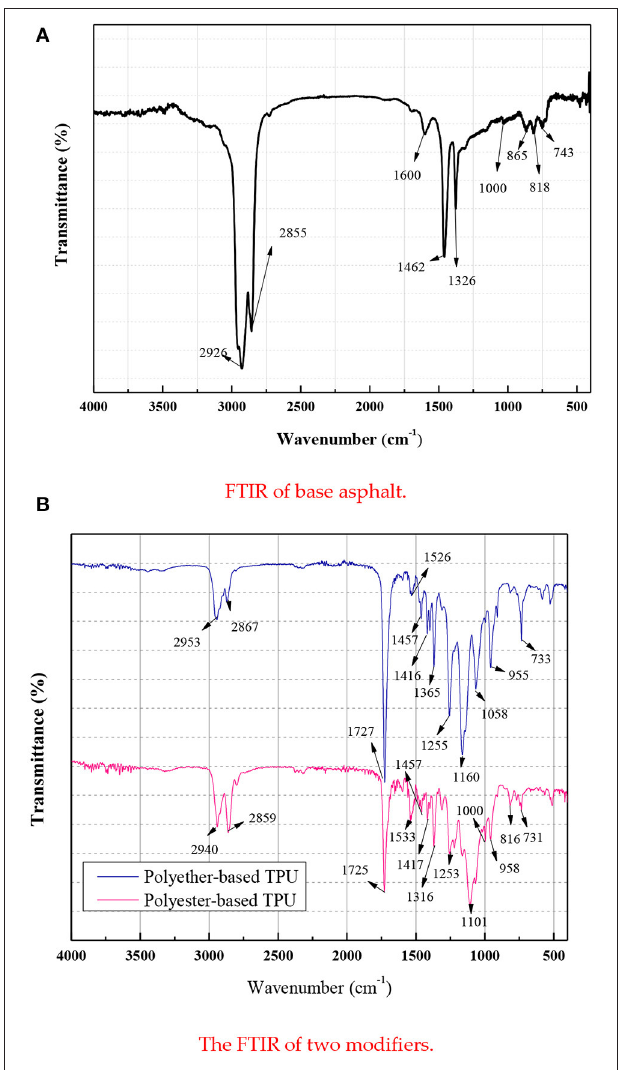
FIGURE 16 | FTIR of raw materials. (A) FTIR of base asphalt. (B) The FTIR of two modifiers.